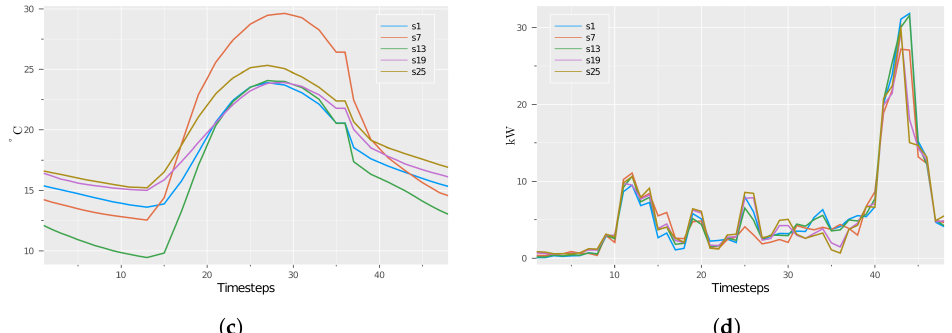
Figure 16. Scenarios created from seasonal naive forecast. ( a ) GHI. ( b ) Wind speed. ( c ) Temperature. ( d ) Power demand.